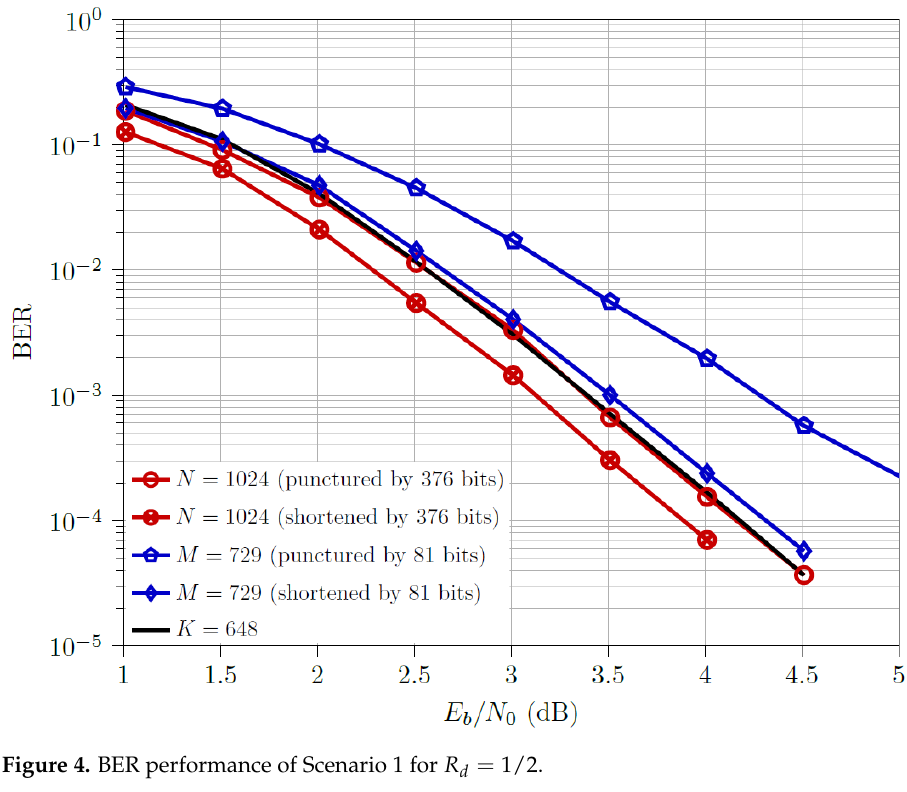
Figure 4. BER performance of Scenario 1 for R d = 1/2.